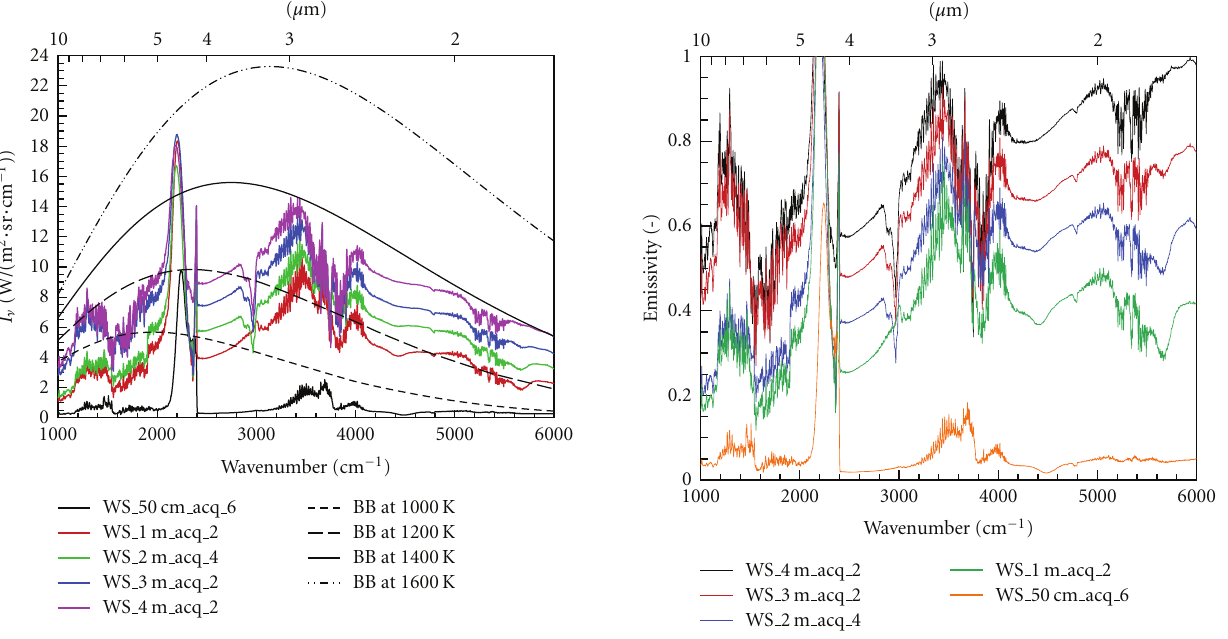
Figure 6: Emissivity computed from maximum emission spectra versus wavenumber (and wavelength). WS are used as fuel, with a fuel load of 1kg/m 2